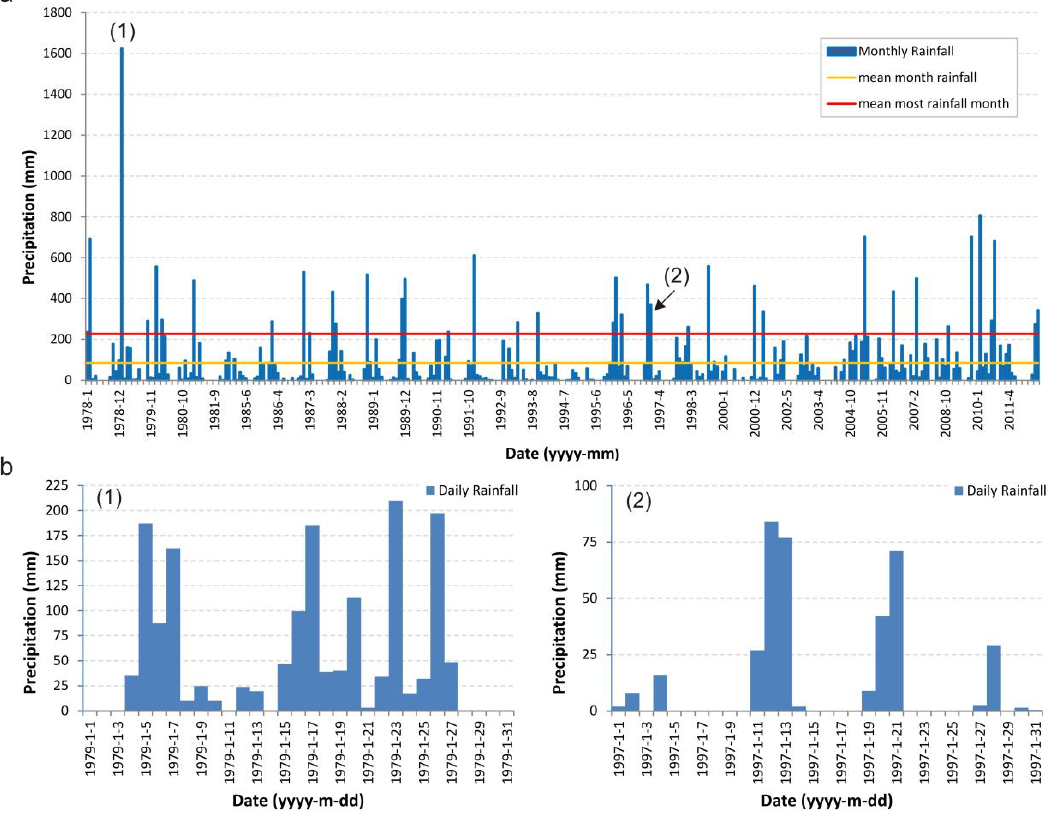
Figure 2. Precipitation record ( a ) for station C106U, downstream of the study area; and precipitation record for two selected months ( b ).